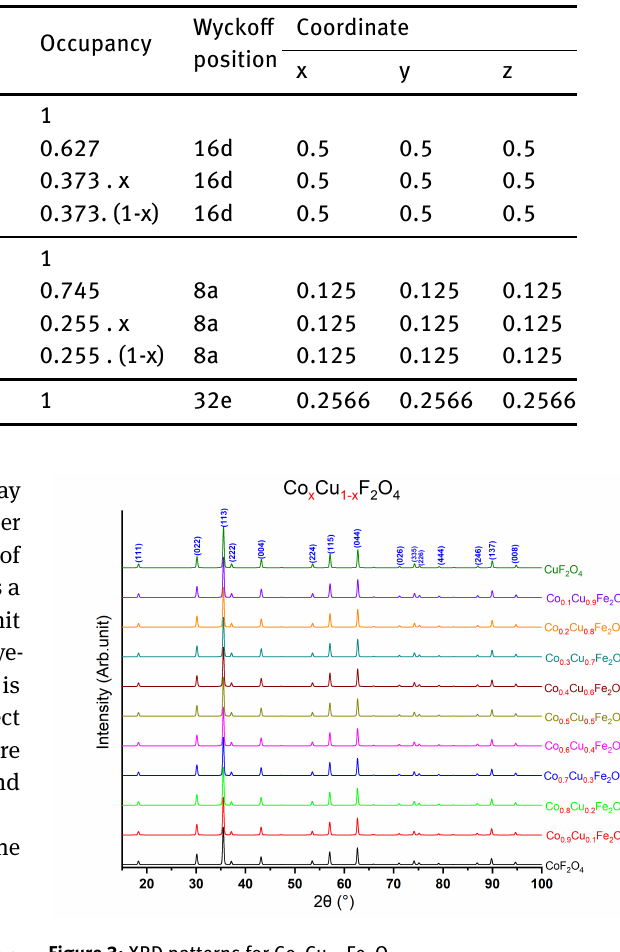
Figure 3: XRD patterns for Co x Cu 1-x Fe 2 O 4